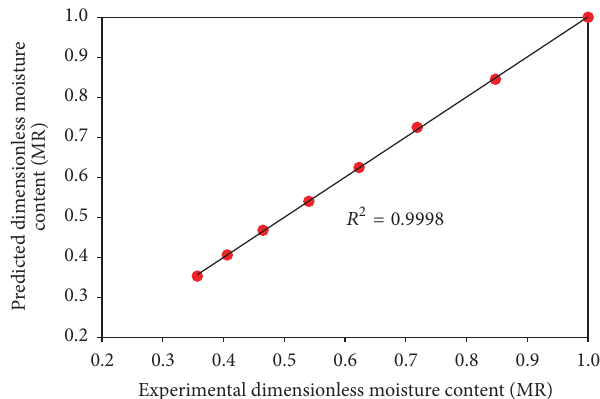
Figure 27: Comparison of experimental dimensionless moisture content (MR) with predicted dimensionless moisture content (MR) from the Page model for the SAHP-FBDIBF for drying of paddy.